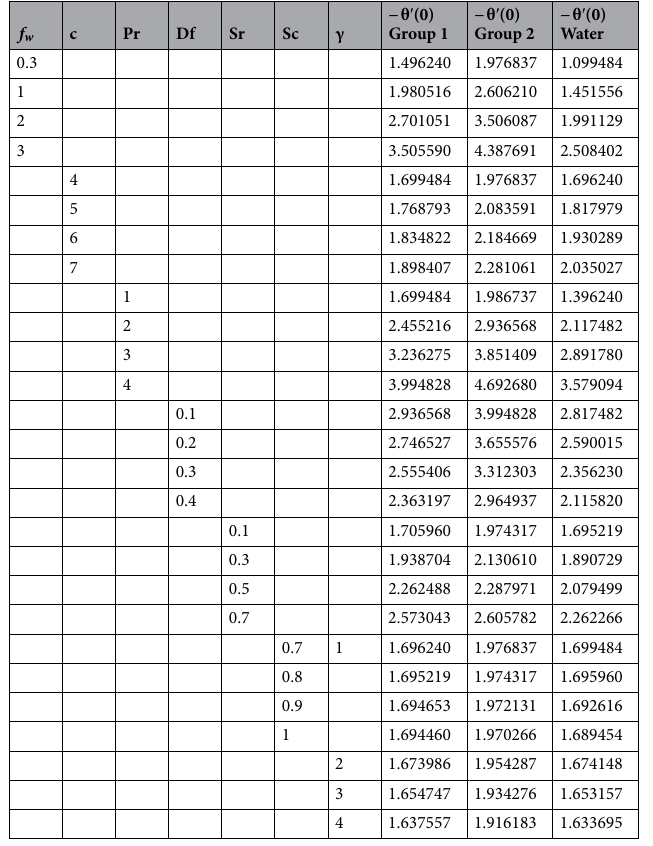
Table 4. Comparative analysis of significance of ( fw , c , Pr , Df , Sr , Sc , γ) on Nusselt number (− θ ′ (0)).